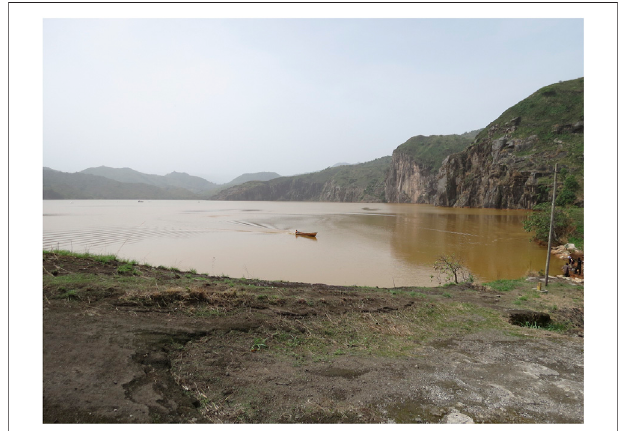
FIGURE 3 | Panoramic view of Lake Nyos, Cameroon, showing the system of the three arti fi cial degassing pipes near the horizon (picture by DR).